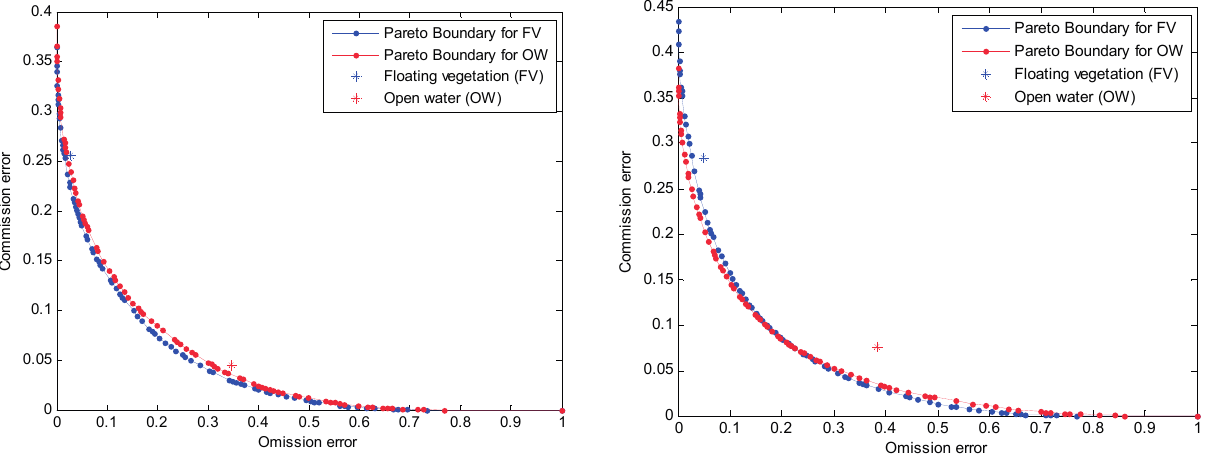
derived from MERIS NDVI with reference f v